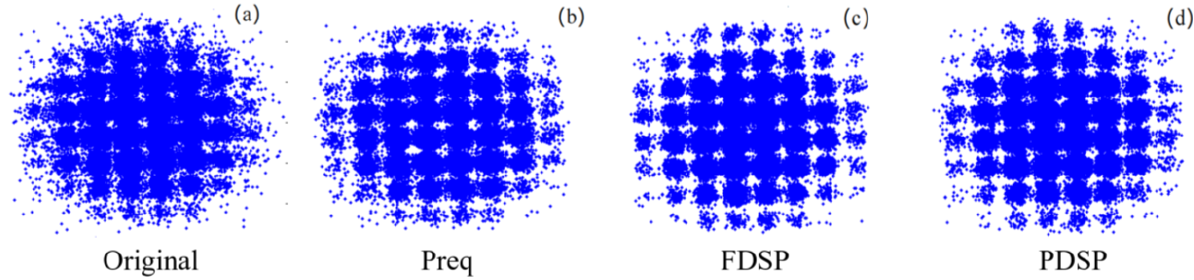
Figure 8. The recovered 64 QAM constellations for ( a ) original scheme, ( b ) pre-equalization, ( c ) WHT-based FDSP and ( d ) fast WHT-based PDSP.